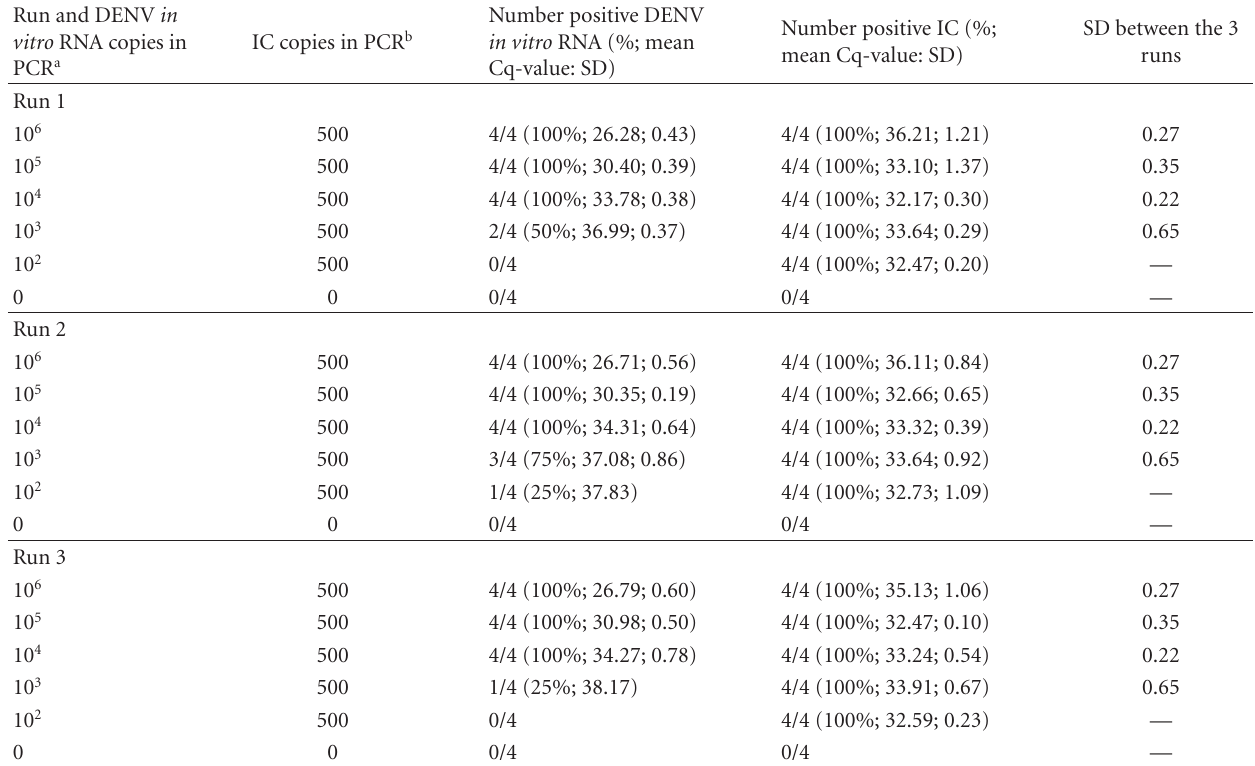
a The inter-assay variation was determined with 10-fold dilution series of DENV in vitro RNA in the presence of a fixed amount of IC spiked into lysis bu ff er containing DENV negative human serum as background and for 4 replicates per each dilution. The variation was determined in three separate runs performed at three di ff erent days. b Number of copies cDNA/PCR has been calculated as 1/12.5 of the extracted RNA, assuming 100% e ffi ciency in extraction, reverse transcription (RT), and PCR. SD: standard